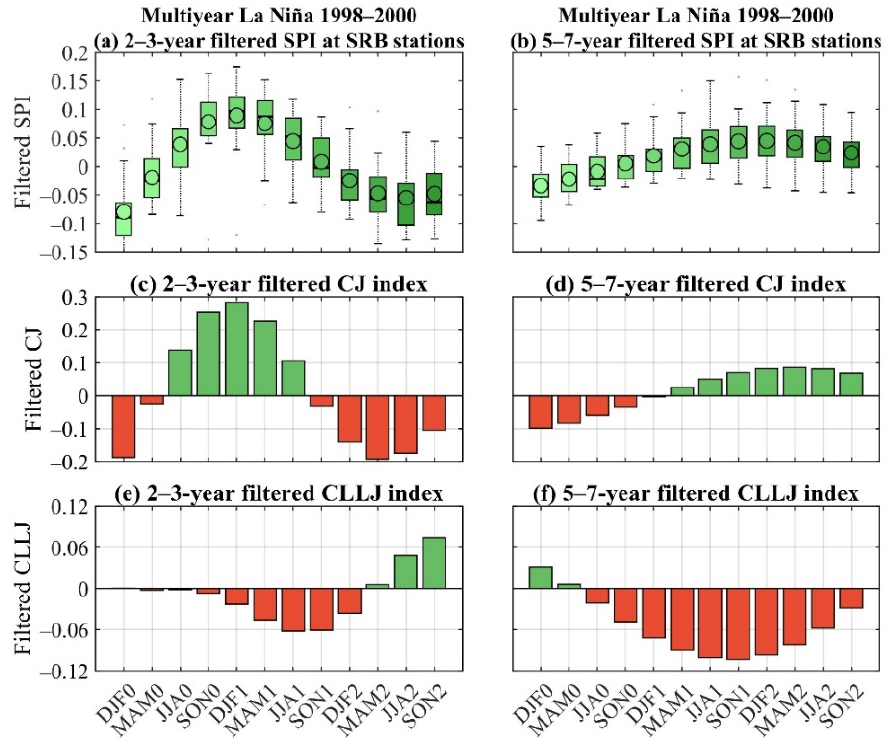
Figure 9. Box plots of the seasonal evolution of the standardized precipitation index (SPI) for the 23 rainfall stations of the Sogamoso River Basin (SRB) filtered at ( a ) quasi-biennial (2–3-year) and ( b ) interannual (5–7-year) scales, as well as seasonal variations of the Choc ó jet (CJ) index on ( c ) quasi-biennial and ( d ) interannual scales and of the Caribbean low-level jet on ( e ) quasi-biennial and ( f ) interannual scales during the 1998–2000 multiyear La Niña. In ( a , b ), each box represents the range between the first and third quartiles divided by the sample’s median, with maximum and minimum values (whiskers) shown by vertical stems. The sample mean is represented by an open dot.